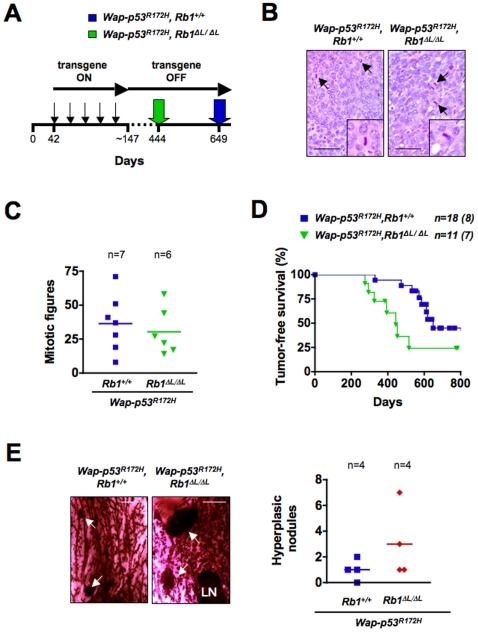
pRB-LXCXE interactions protect against tumor formation caused by the Wap-p53R172H transgene.A) Experimental outline for the Wap-p53R172H tumor study. Mice were bred through five rounds of pregnancy (thin arrows) to transiently induce p53R172H expression within the mammary gland. After the fifth pregnancy, males were removed and females were palpated weekly to monitor tumor formation. Median tumor-free survival for each genotype is marked with the colored arrows. B) Representative H&E stained paraffin sections from tumors harvested from Wap-p53R172H; Rb1+/+ and Wap-p53R172H; Rb1ΔL/ΔL mice. Arrows indicate mitotic figures that are shown in the inset. Scale: 50 µm. C) The mitotic index for Wap-p53R172H; Rb1+/+ and Wap-p53R172H; Rb1ΔL/ΔL mice is indicated, along with the average mitotic index for each genotype. Values were derived by quantifying the number of mitotic figures in five random fields of view for each mouse. D) Kaplan-Meier graph of mammary tumorigenesis is shown for Wap-p53R172H; Rb1+/+ and Wap-p53R172H; Rb1ΔL/ΔL females (log rank test; P = 0.0238). Values in brackets indicate the number of mice that developed tumors. E) Carmine Red–stained mammary whole mounts from tumor-free glands in mice that had mammary tumors are shown for both genotypes in the Wap-p53R172H background. Arrows indicate hyperplastic nodules and LN indicates lymph nodes. Scale: 2 mm. The number of hyperplastic nodules in each whole mount section was also quantified for each genotype along with the average number of hyperplastic nodules.